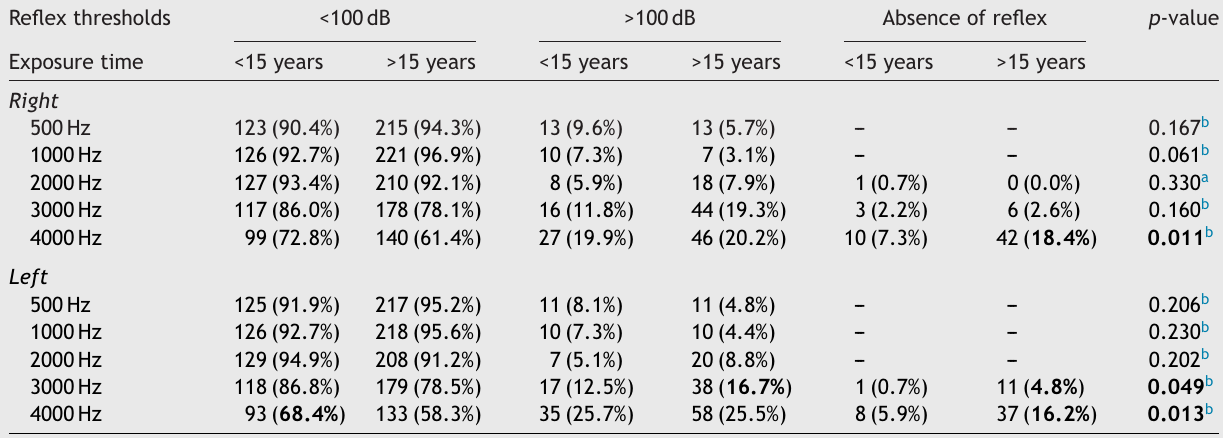
Comparison between noise exposure time and contralateral stapedial reflex thresholds ( n = 364). Reflex